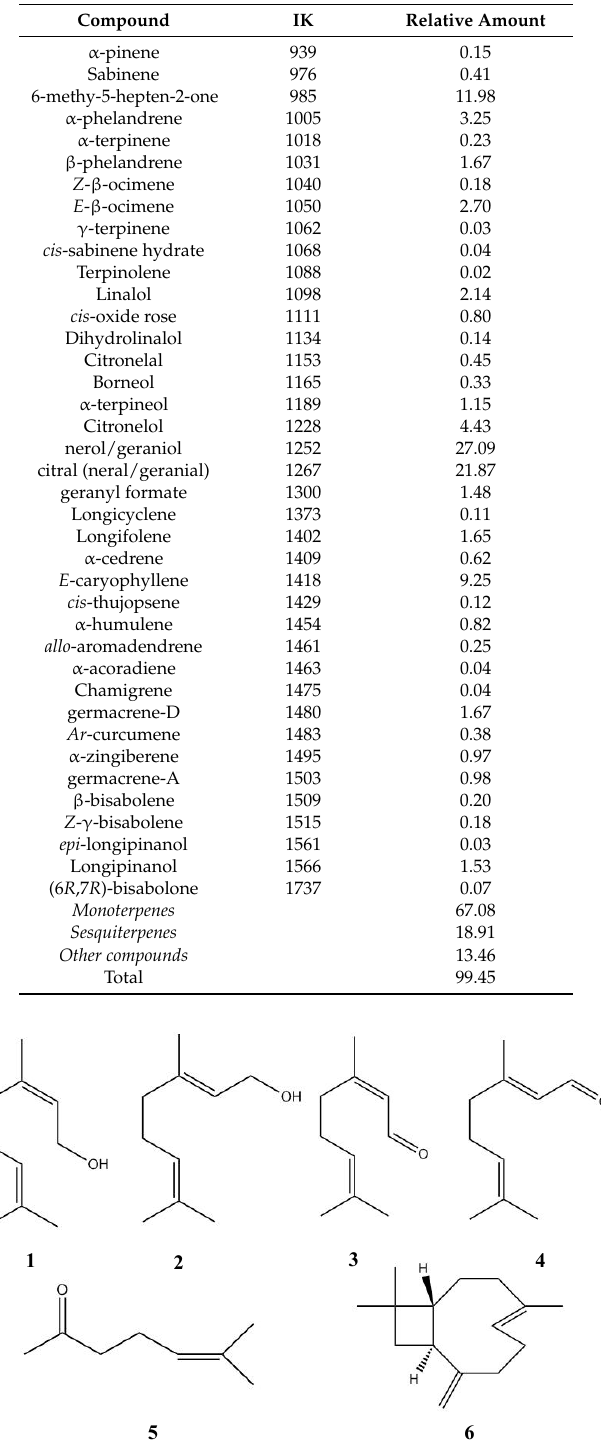
Table 2. Chemical composition of the essential oil obtained from leaves of L. alba .